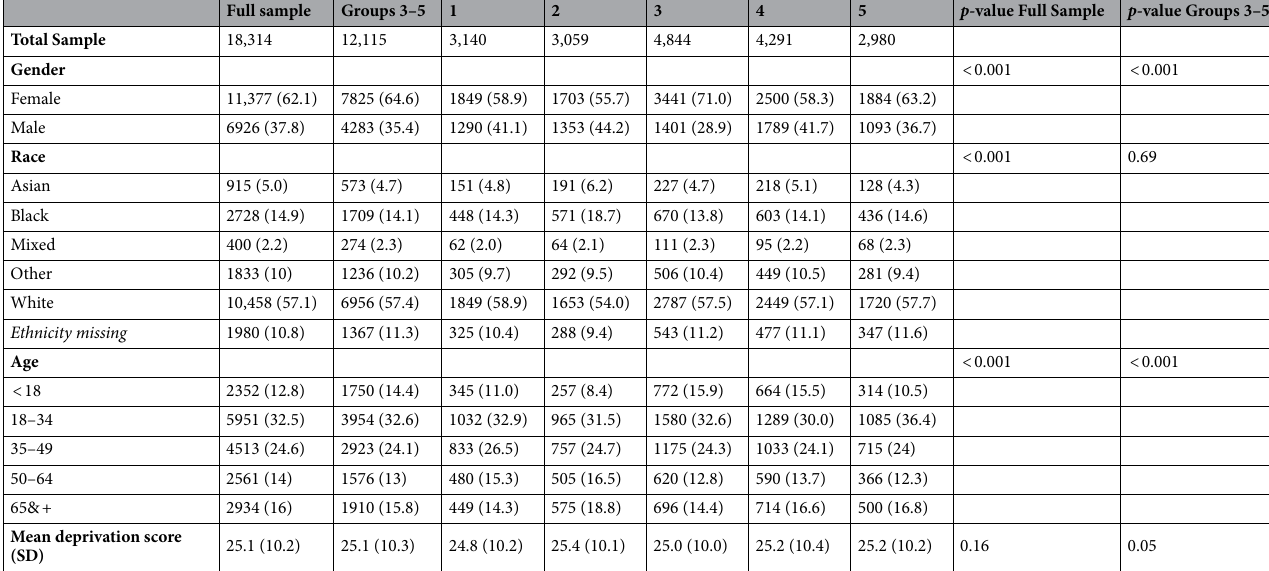
Table 1. Demographic information for the total sample as well as within patient